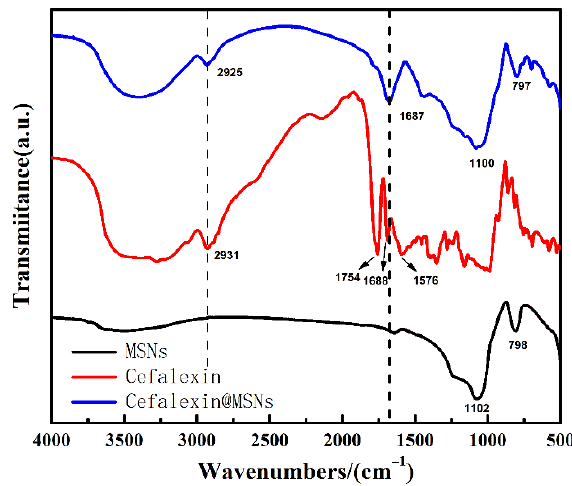
Figure 2. The FTIR spectra of MSNs, cefalexin, and cefalexin@MSNs.